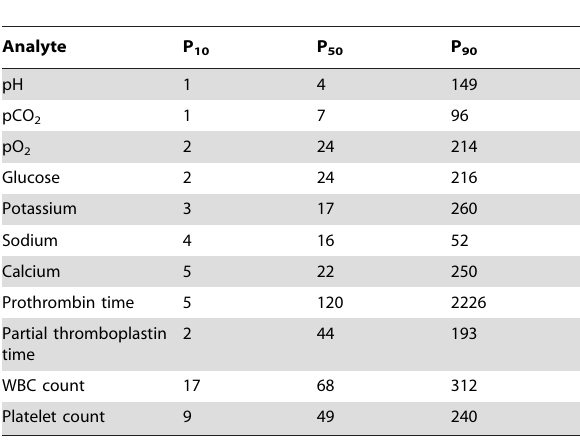
Table 3. The Interval for Each Repeat Critical Value